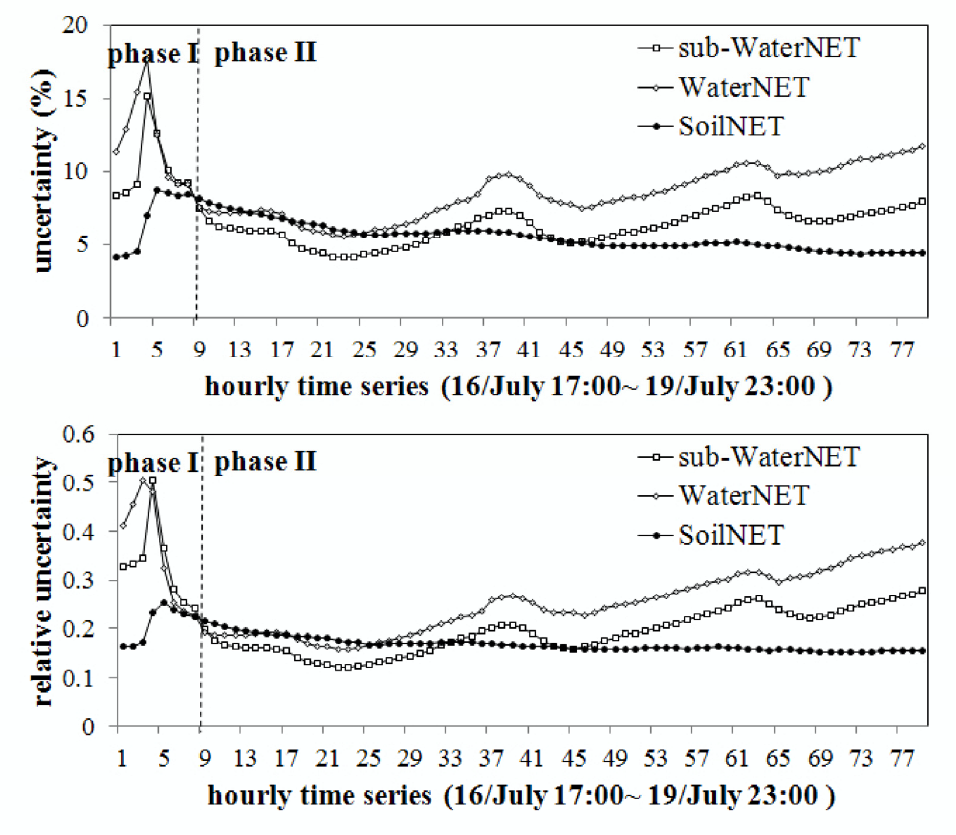
Figure 7. The absolute ( top ) and relative ( bottom ) uncertainties of SoilNET, sub-WaterNET and